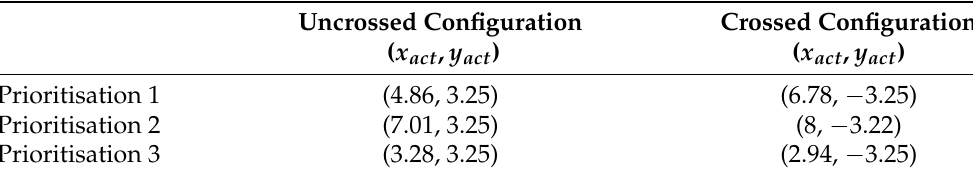
Figure 14. Resulting optimal actuator placement. Black lines are optimal placement with uncrossed cable configuration, and grey lines are optimal placement if crossed configuration is used. ( a ) κ x = 1, κ y = 1. ( b ) κ x = 4, κ y = 1. ( c ) κ x = 1, κ y = 4. Table 4. Test case resulting optimal actuator placement as defined in